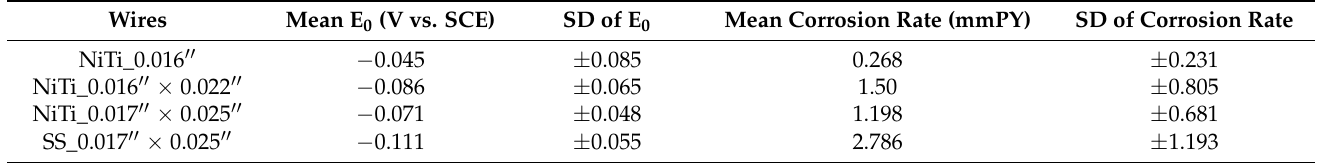
Table 3. The results for the mean corrosion potential E corr at each of the five cycles versus SCE.